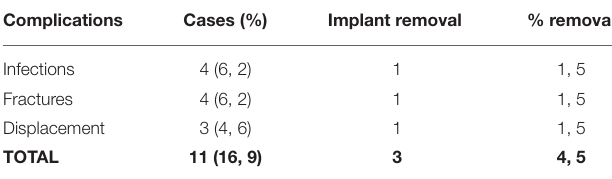
TABLE 4 | Complications reported in the 65